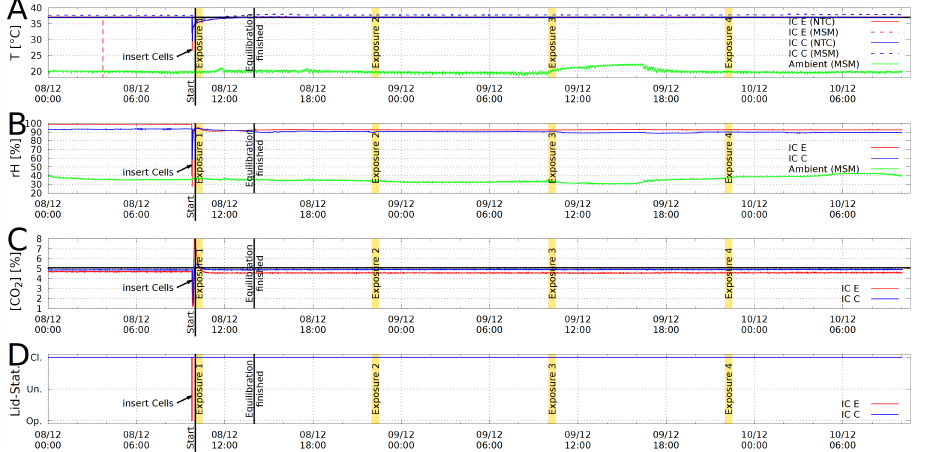
Figure 4. Example for a log file plot from Incubator C (blue curves) and E (red curves). ( A ): Temper- ature T in [ ◦ C]; ( B ): relative humidity rH in %; ( C ): CO 2 concentration [CO 2 ] in %; ( D ): Lid status open/undefined/closed. Exposure durations are marked yellow and the ambient temperatures are represented by green lines. Double temperature measurement with negative temperature coefficient NTC sensor (solid) and a multisensor module (MSM,